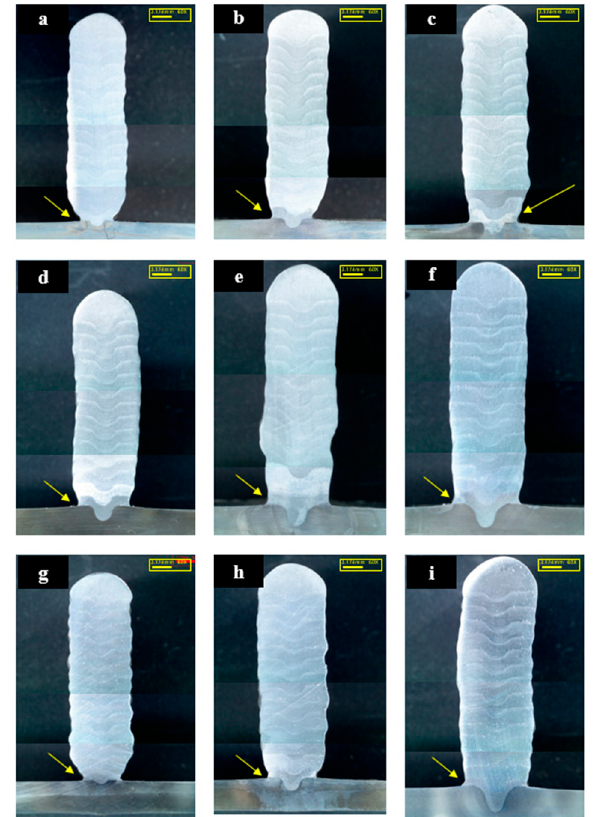
Figure 4. Macro-section images of a multi-layer bead according to MIG welding conditions of ( a ) 80 A, 17.1 V; ( b ) 87 A, 17.5 V; ( c ) 92 A, 18 V; ( d ) 102 A, 18.3 V; ( e ) 110 A, 18.4 V; ( f ) 118 A, 18.9 V; ( g ) 83 A, 16 V; ( h ) 95 A, 16.5 V; ( i ) 112 A, 17.2 V.